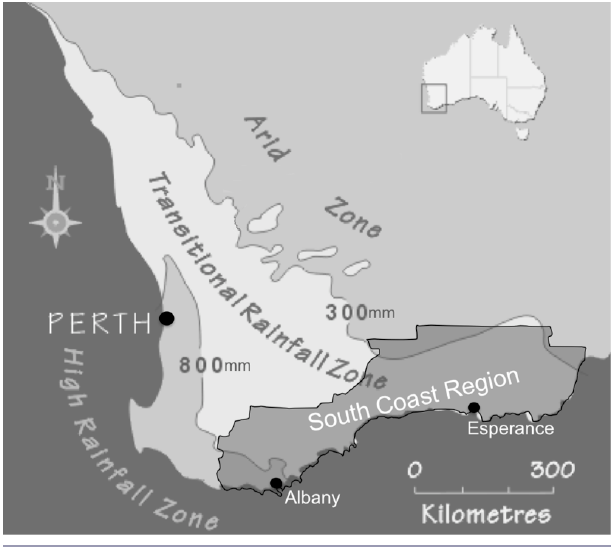
Fig. 1 . Southwest of Western Australia indicating the rainfall gradients and the boundaries of the South Coast